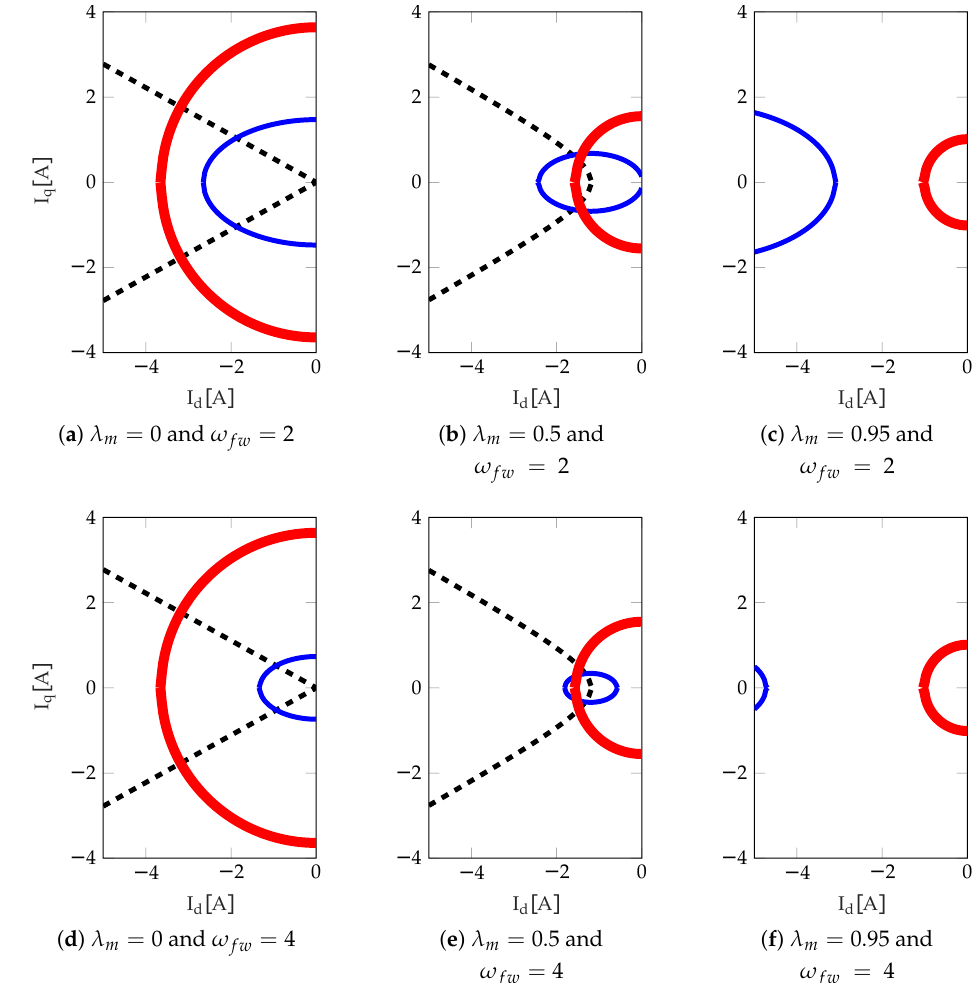
Figure 4. Voltage, current limits and MTPV curve at various PM flux λ m and speed ω